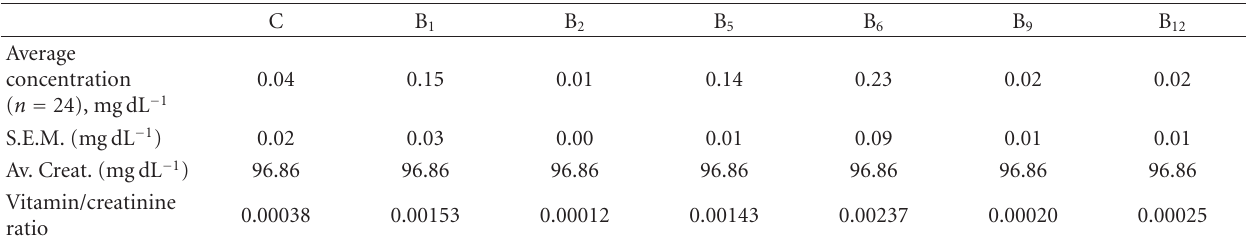
Table 7: Average concentration of individual water-soluble vitamins ( ± SEM) in urine samples obtained from study